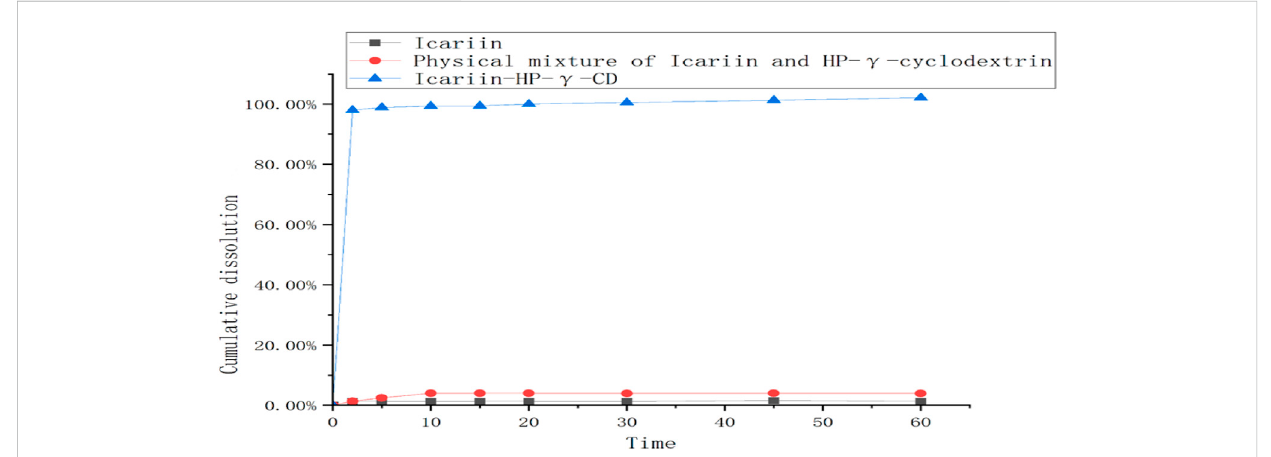
FIGURE 9 The dissolution curves of icariin, the mixture of icariin and HP- γ -cyclodextrin, and their complex.